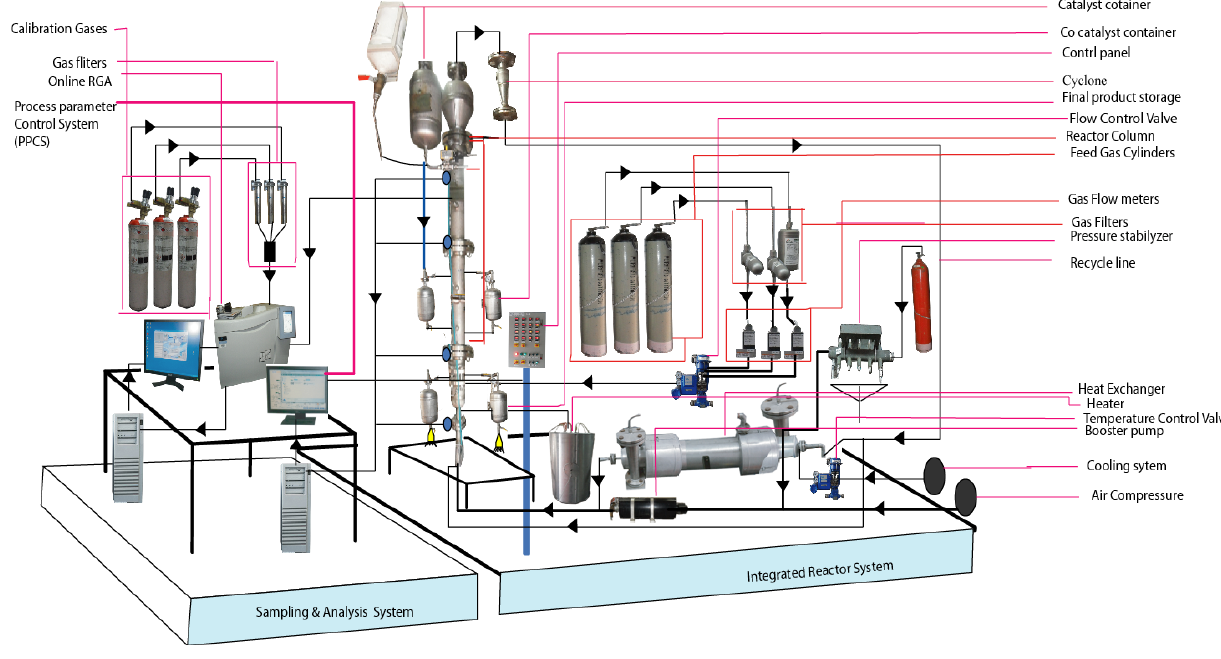
Figure 2. Detailed experimental set up of a pilot scale fluidized bed catalytic reactor